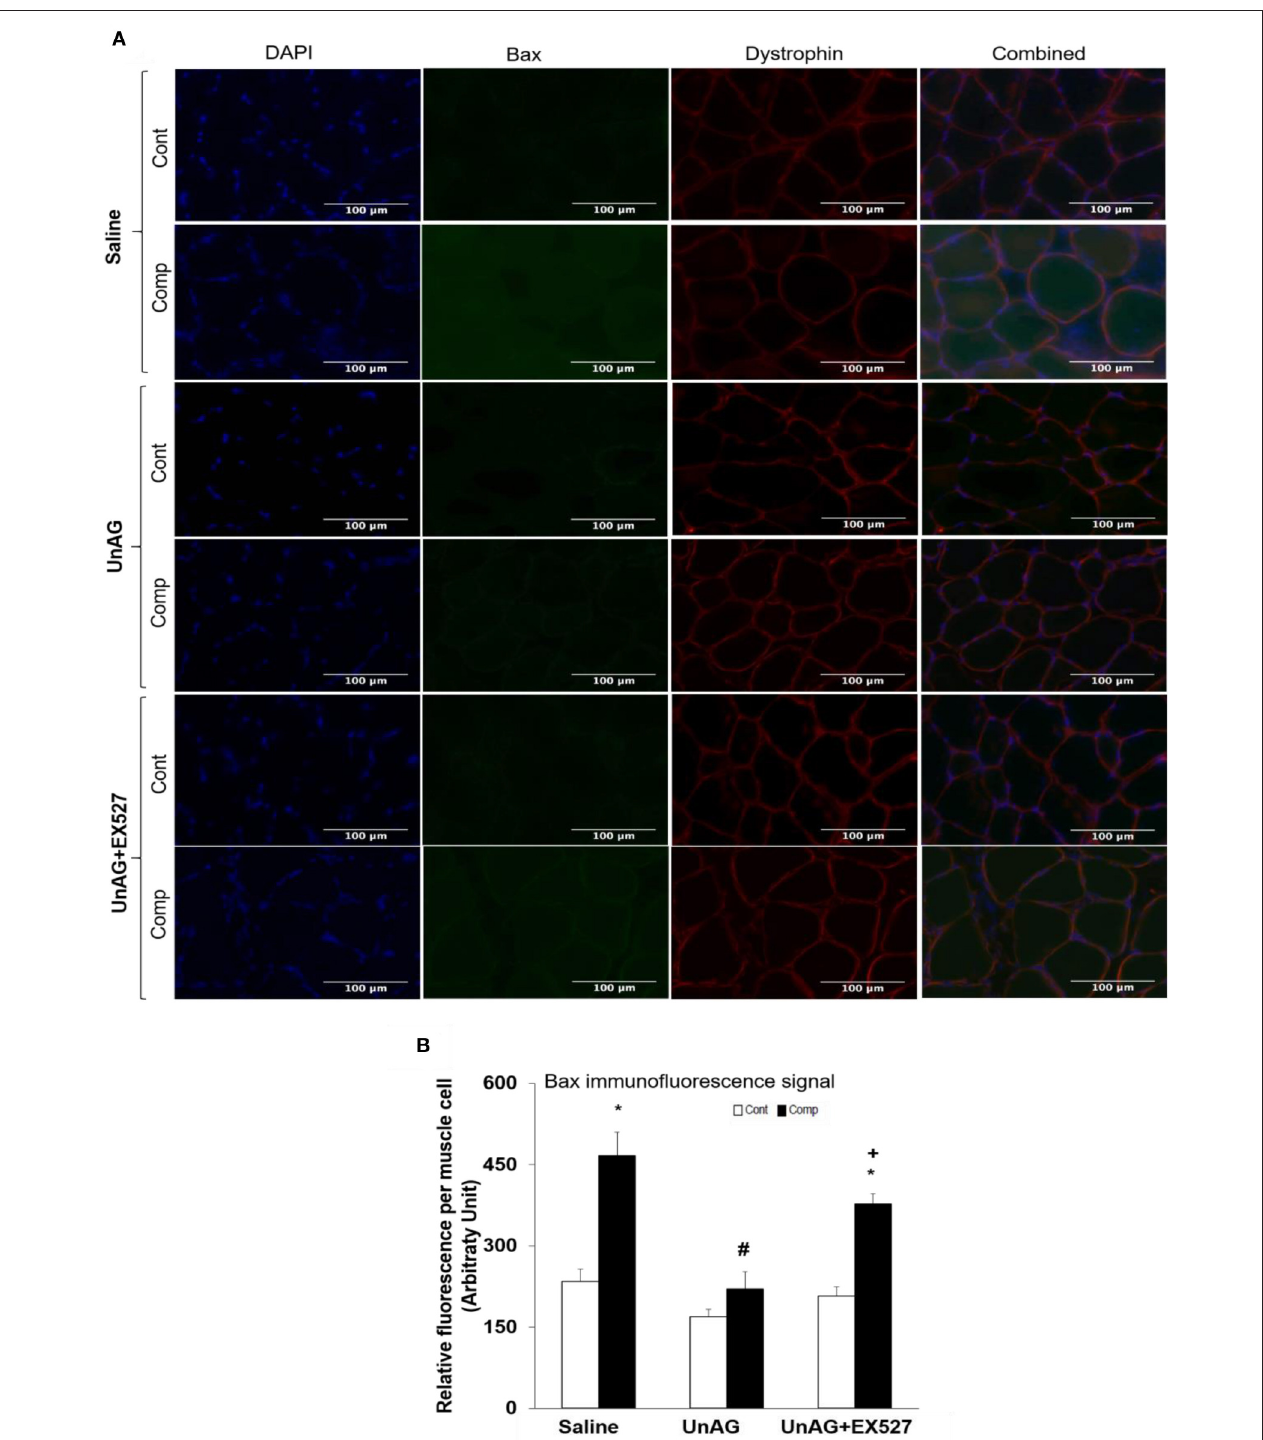
FIGURE 3 | Immunofluorescence staining of Bax and dystrophin. Representative images of compressed and uncompressed muscles labeled with anti-dystrophin (red) and anti-bax (green) (A) . Muscle Bax signal was increased in compressed muscles treated with saline and UnAG + EX527 (A) . In contrast, muscle Bax abundance was decreased in compressed muscles treated with only UnAG (A) . Quantification of relative fluorescence intensity of Bax (B) . * p < 0.05, compressed muscle compared to uncompressed control muscle; # p < 0.05, UnAG compared to Saline; + p < 0.05, UnAG + EX527 compared to UnAG; Cont, control muscle; Comp, compressed